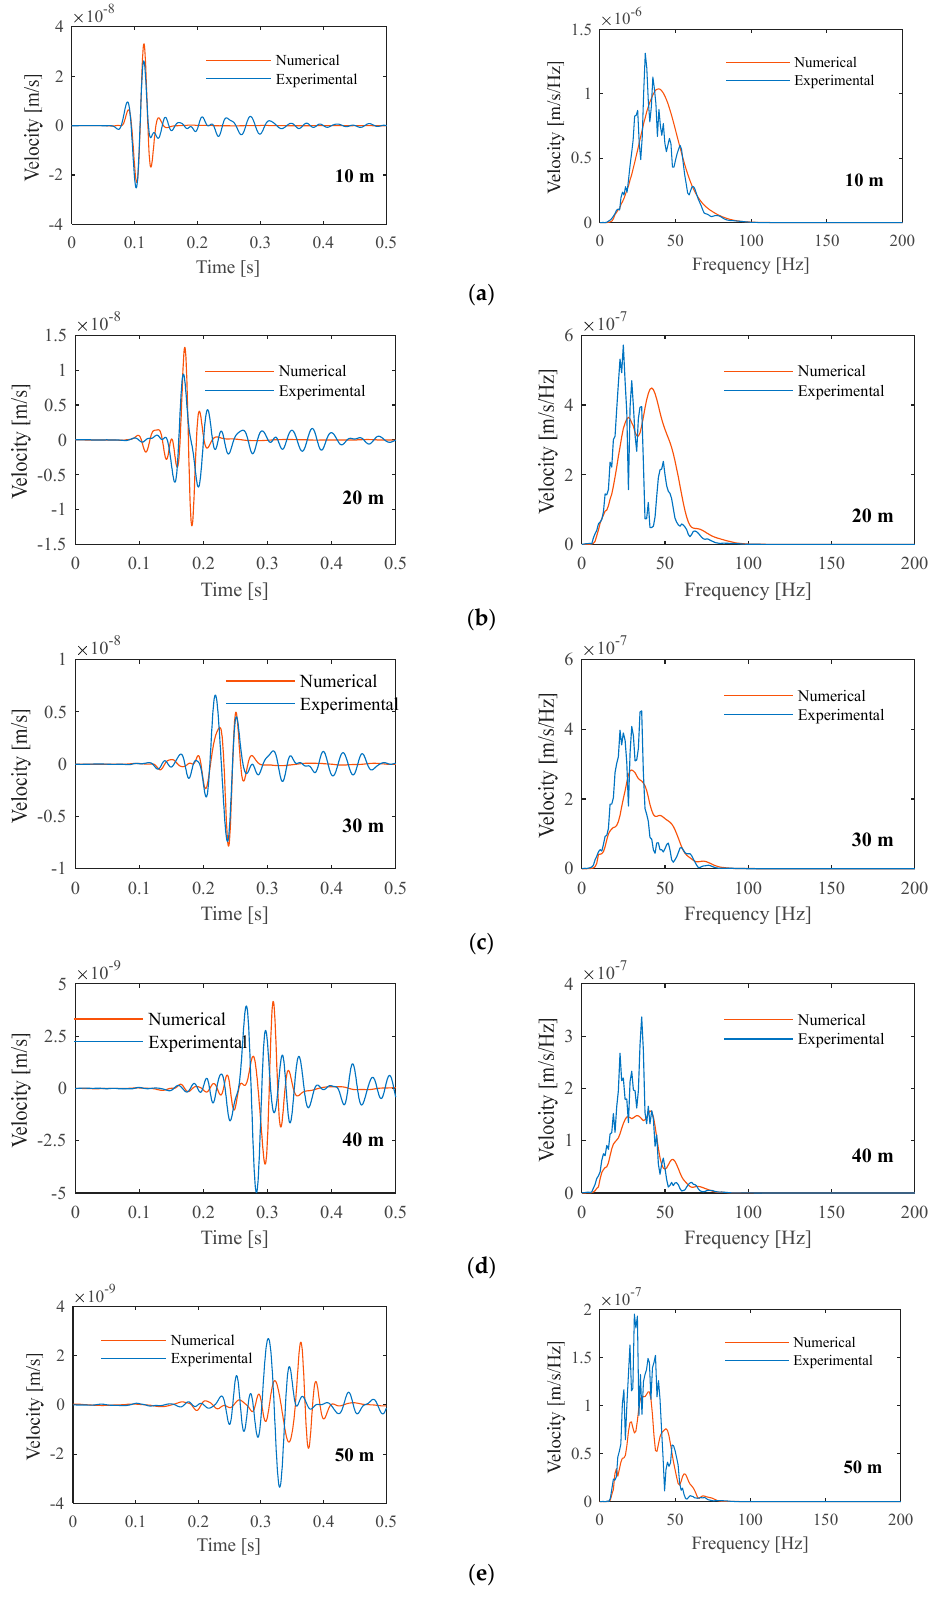
Figure 13. Experimental velocities of vertical vibration measured at different distances from the pile compared to the numerical prediction for a material damping ratio equal to 0.025: ( a ) 10 m; ( b ) 20 m; ( c ) 30 m; ( d ) 40 m; ( e ) 50 m (left: time history; right: frequency